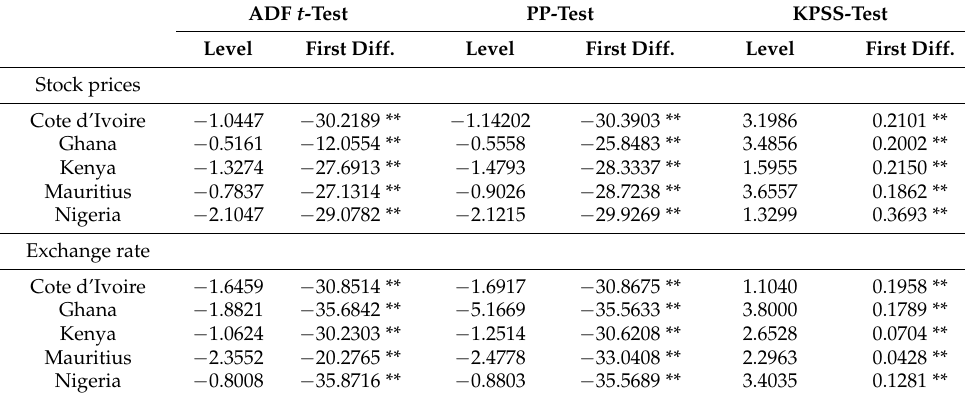
Table 3. Unit root and stationary